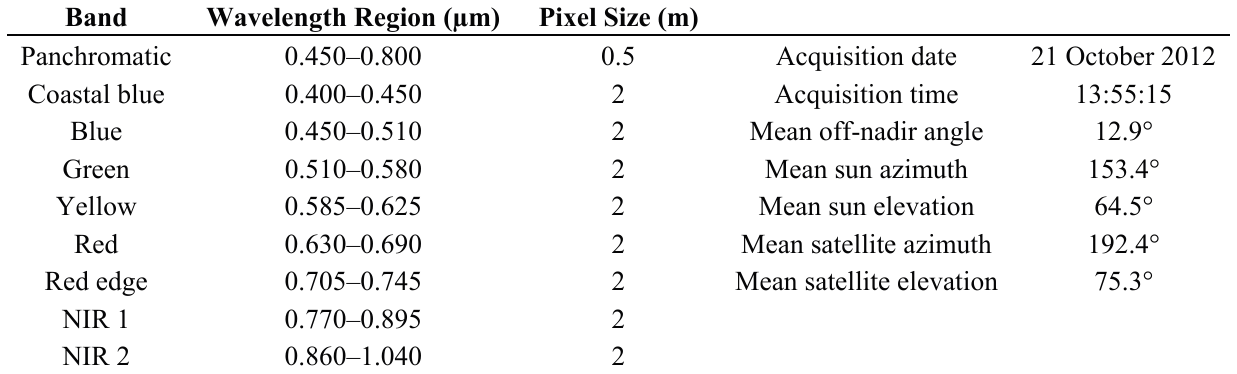
Table 1. Technical specifications of the WorldView-2 image acquired 21 October 2012 (Source: Digital Globe